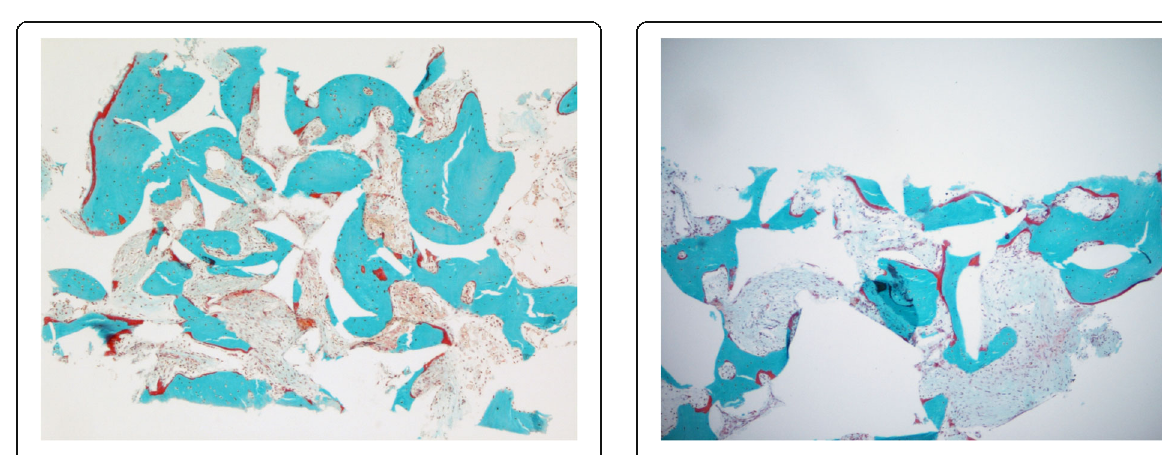
Fig. 5 Patient # 4 (9-month healing time): increased bone formation following the shape of the grafted particles stained with Goldner trichrome staining (magnification ×100)